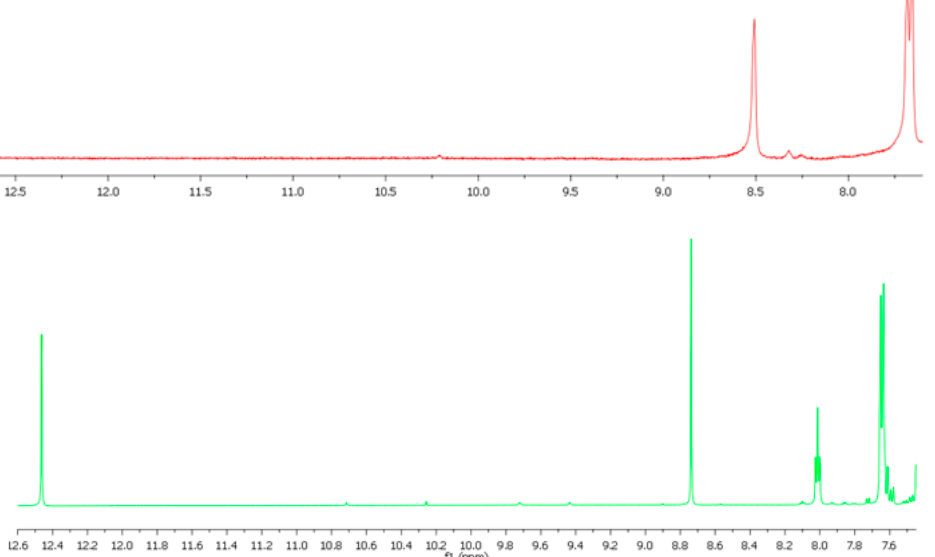
Figure 4. Partial view of the 1 H NMR spectra of H 2 SB (bottom) and Zn 2 (SB) 2 · 4H 2 O (top).